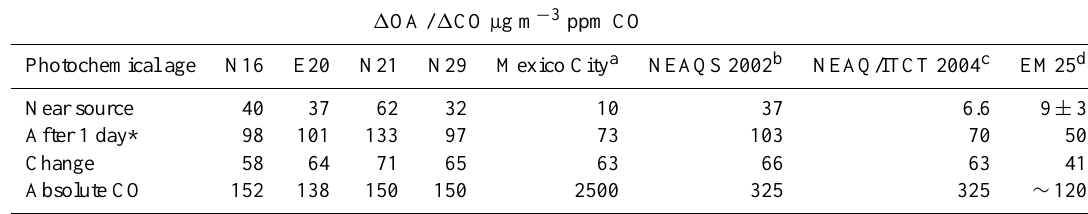
Table 3. Comparison of the change in 1 OA/ 1 CO measured in different regions.